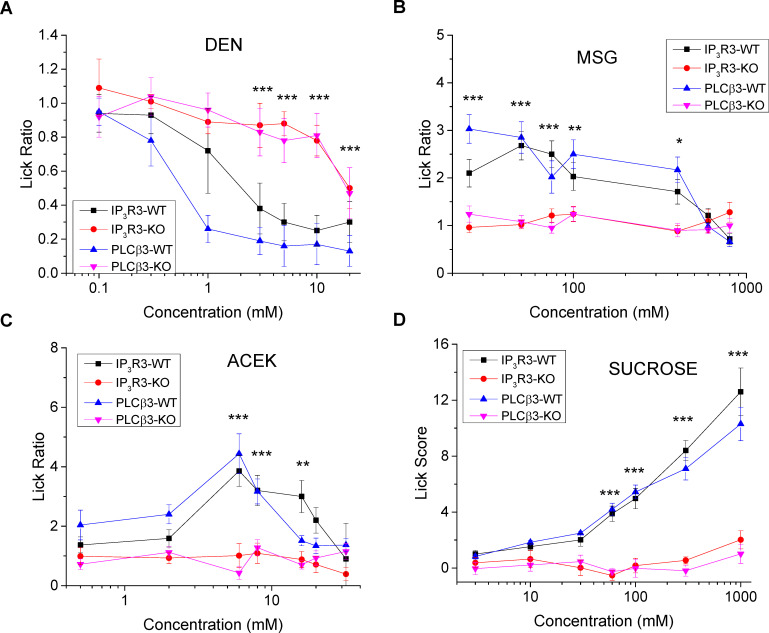
Loss of PLCβ3 or IP3R3 affects behavioral responses to taste stimuli.Average lick data (±standard deviation) from brief-access behavioral tests compare the responses of IP3R3-KO (red line) and PLCβ3-KO (pink line) to WT (IP3R3-WT, black line; PLCβ3-WT, blue line). A) Lick ratios (stimulus/water) of the WT mice for the bitter stimulus denatonium (DEN, 0, 0.1, 0.3, 1, 3, 5, 10, 20mM) were significantly different from the IP3R3-KO and PLCβ3-KO responses. B) Lick ratios of the WT mice for the umami stimulus monosodium glutamate + 10μM amiloride (MSG, 0, 25, 50, 75, 100, 400, 600, 800mM) were significantly different from the IP3R3-KO and PLCβ3-KO mice. C) Lick ratios of the WT mice for the artificial sweetener acesulfame K (ACEK, 0, 0.5, 2, 6, 8, 16, 20, 32mM) were significantly different from the IP3R3-KO and PLCβ3-KO mice. D) Lick scores (stimulus-water) of the WT mice for sucrose (0, 3, 10, 30, 60,100, 300, 1000mM) were significantly different from the IP3R3-KO and PLCβ3-KO responses. For all experiments, 5 mice of each genotype were used (***, p<0.001; **, p<0.01; *, p<0.05). Data were compared by repeated measures ANOVA. Significant interaction terms were followed by Tukey’s Honestly Significant Difference tests.